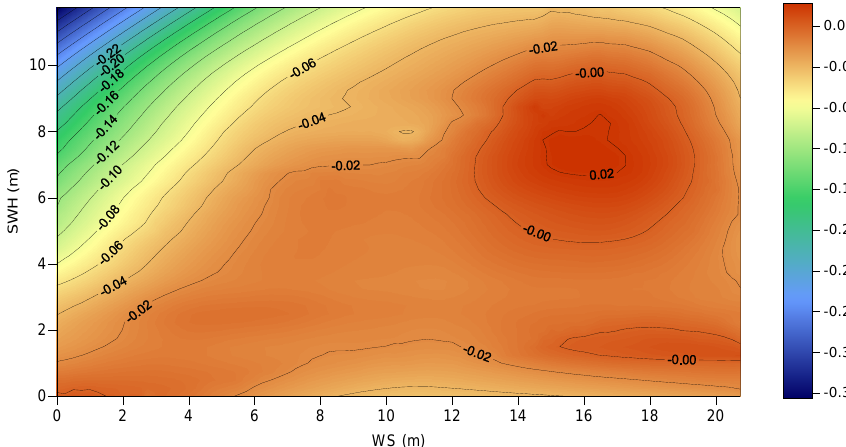
Figure 12c – Difference between Labroue and Chambers SSB models for TOPEX B